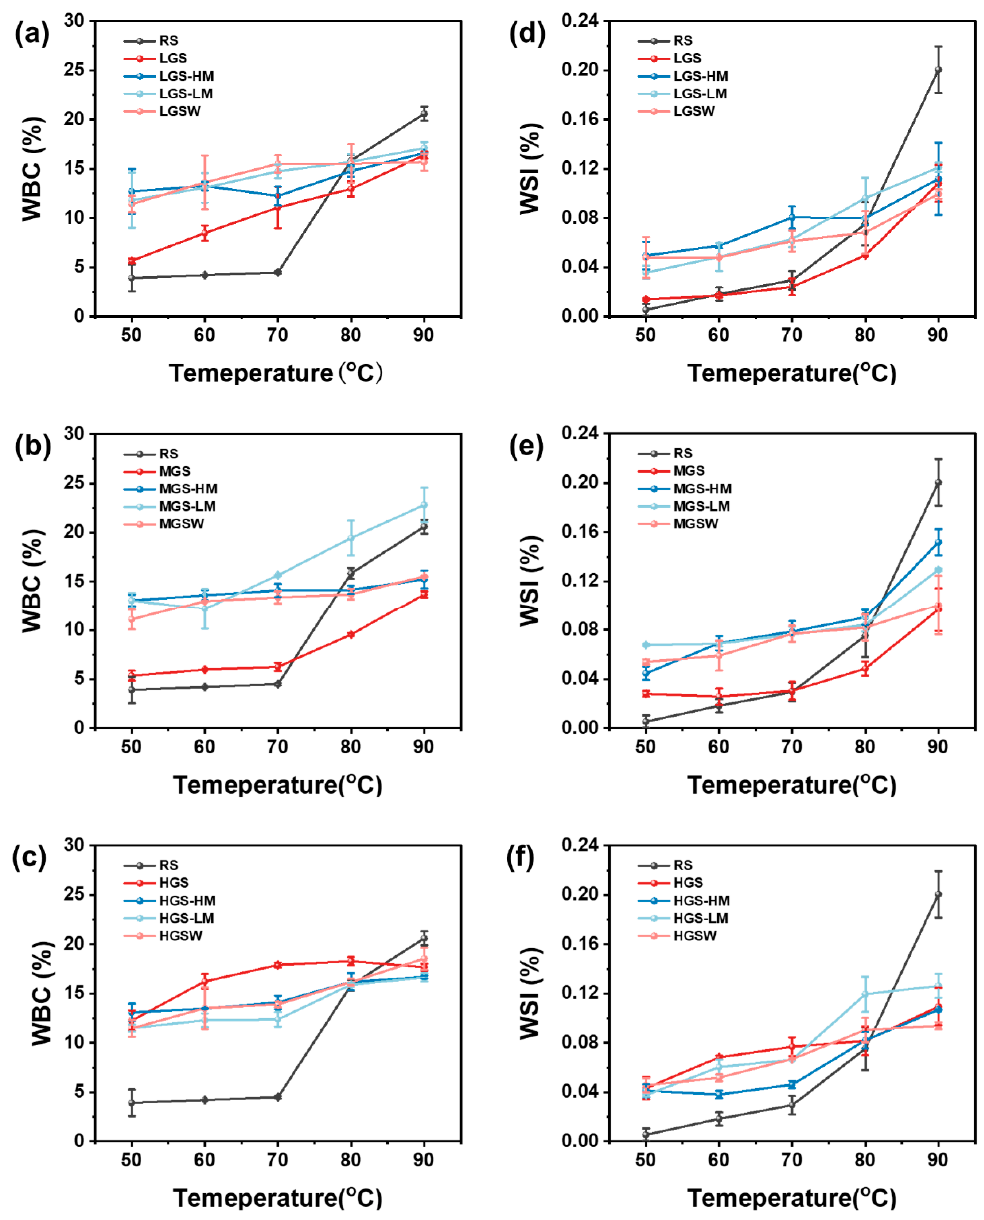
Figure 5. WBC ( a – c ) and WSI ( d – f ) of PGSs reheated by different methods.